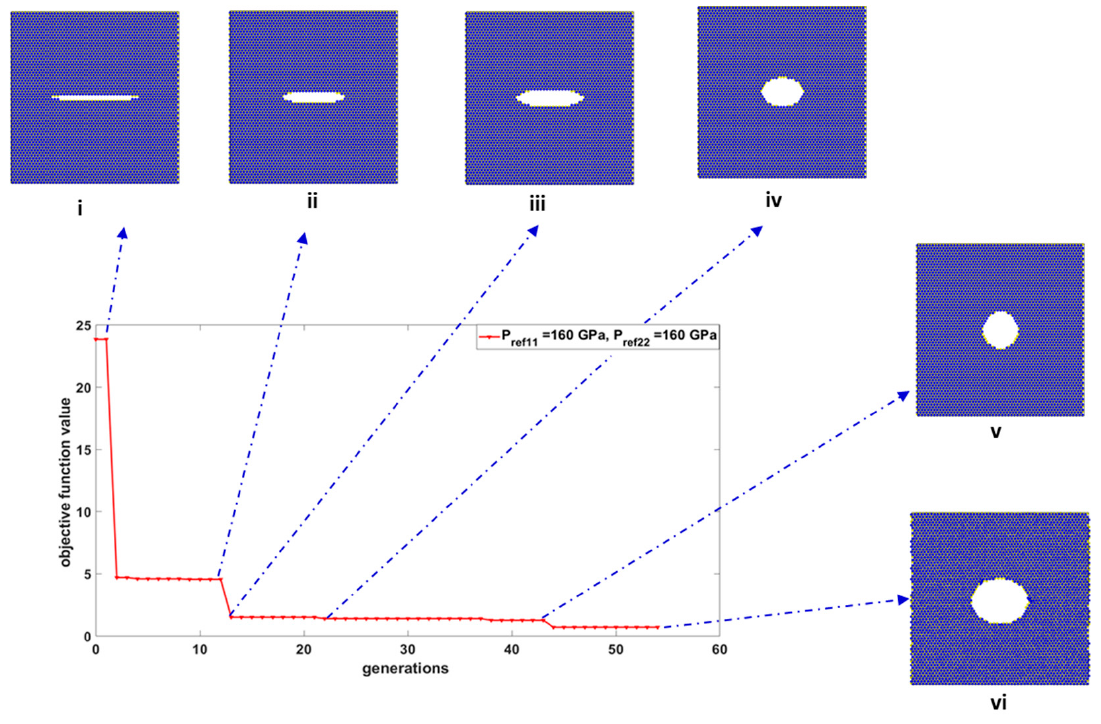
Figure 5. Progress of the convergence of the objective function indicating the evolution of the void during iterative generations for prescribed elastic properties P ref 11 = 160 GPa, P ref 22 = 160 GPa. The corresponding void dimensions obtained during generations were (i) g 1 = 46.06 Å and g 2 = 2.95 Å,